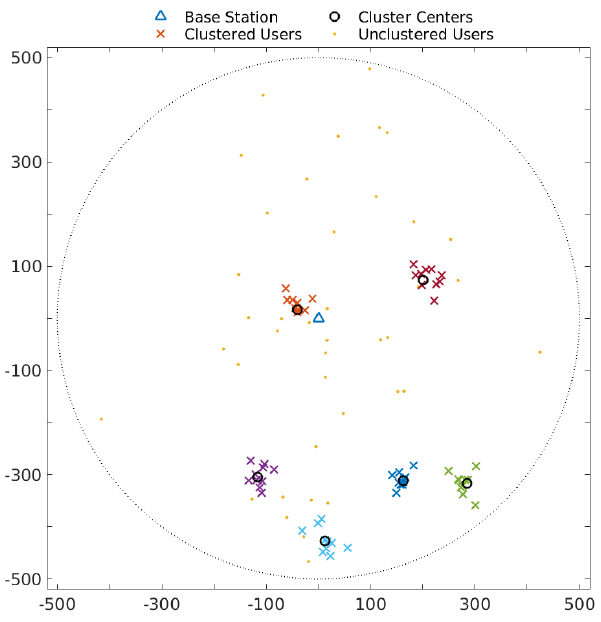
Figure 1. Sample topology. Axes represent distance in